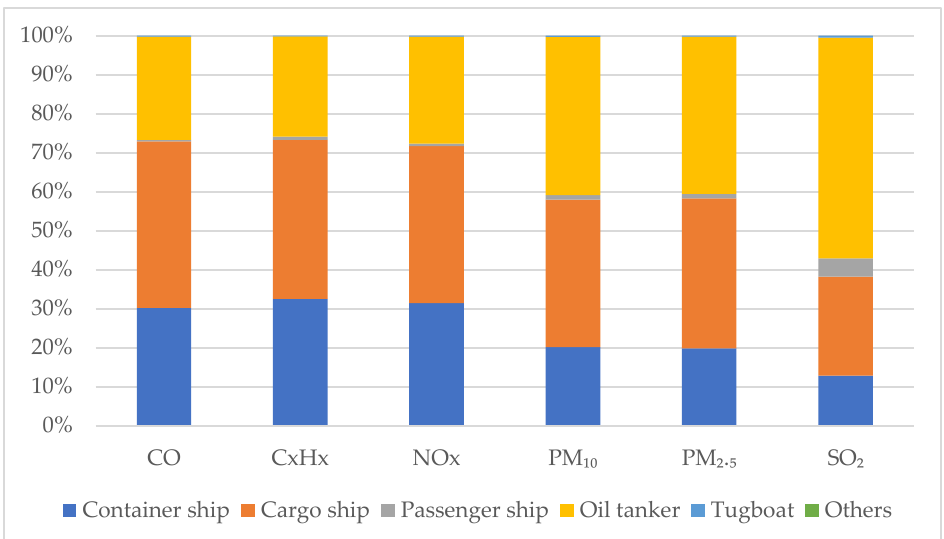
Figure 7. Pollutant emission proportions of various ship types.